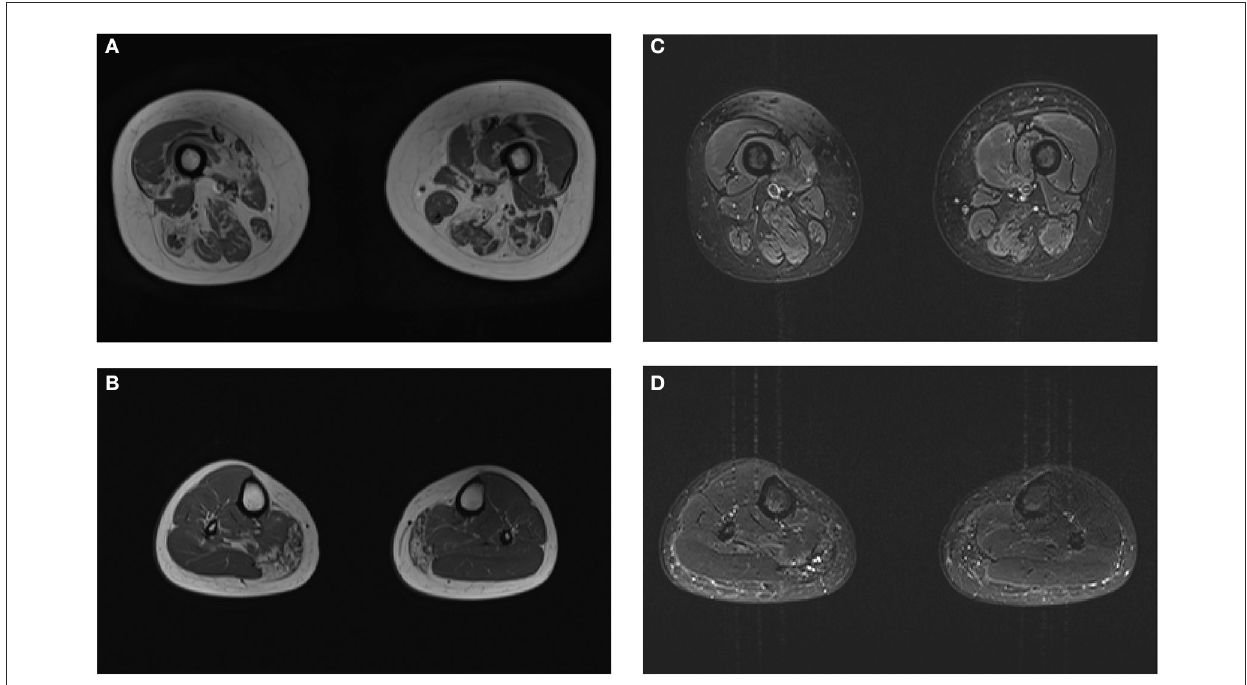
FIGURE1 Magnetic resonance imaging (MRI) images of the patient. Muscle MRI shows the geographic distribution of muscular fatty infiltration. The predominantly affected muscles included the quadriceps femoris and posterior compartment in the thighs (A) and medial gastrocnemius with sparing of anterior tibialis in the lower legs (B) . No muscle edema was seen in the proband (C, D)